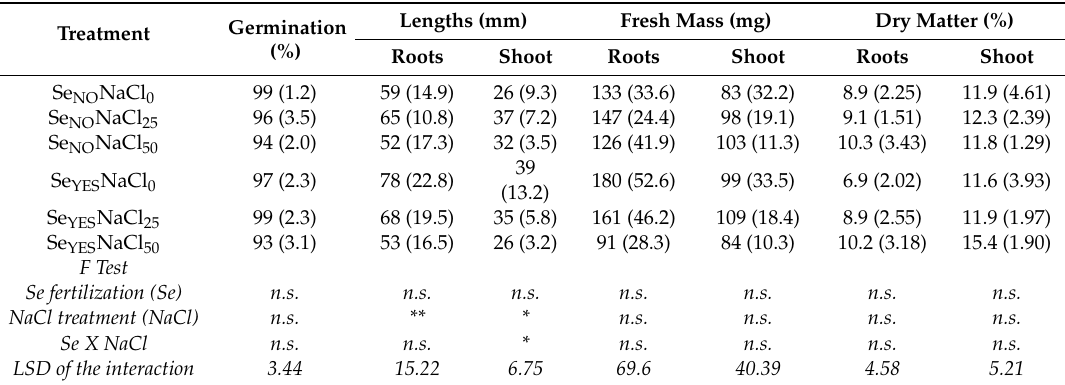
Table 1. Germination percentage, shoot and root lengths, individual total fresh mass, and dry matter concentration of maize sprouts obtained at 0, 25, or 50 mM NaCl (i.e., NaCl 0 , NaCl 25 , and NaCl 50 , respectively) from grains produced without or with Se fertilization (i.e., Se NO and Se YES , respectively). Lengths (mm) Fresh Mass (mg) Dry Matter (%) Treatment Germination (%) Roots Shoot Roots Shoot Se NO NaCl